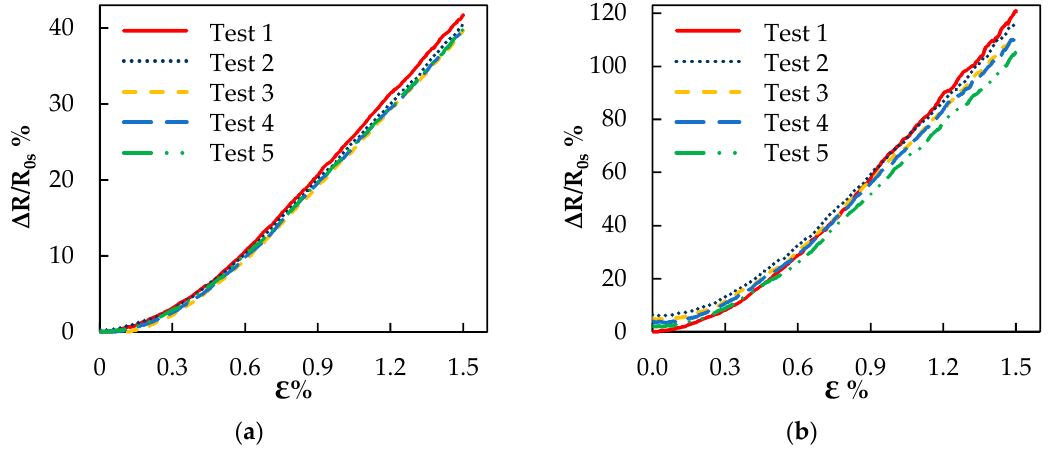
Figure 9. ( a ) Normalized variation of electrical resistance ∆ R / R 0 s % as a function of strain during monotonic tests for sensor produced via the capillary rise method; ( b ) normalized variation of electrical resistance ∆ R / R 0 s % as a function of strain during monotonic tests for the sensor produced via the resin casting method.